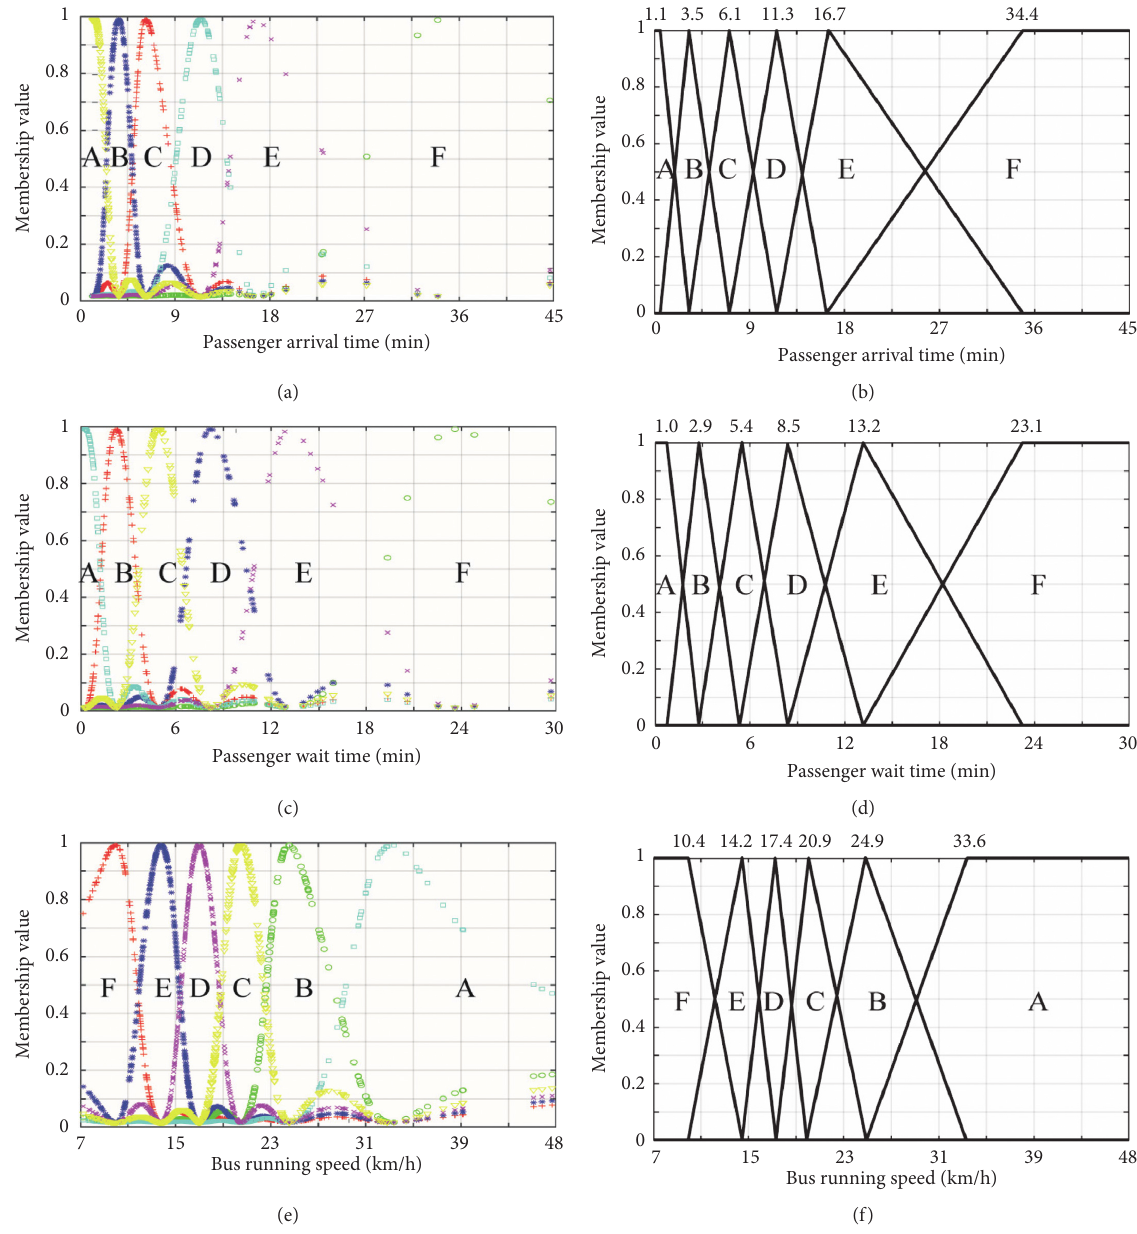
Figure 2: Membership functions for the calm passenger group. (a, c, and e) The original membership functions; (b, d, and f) the ap- proximated membership